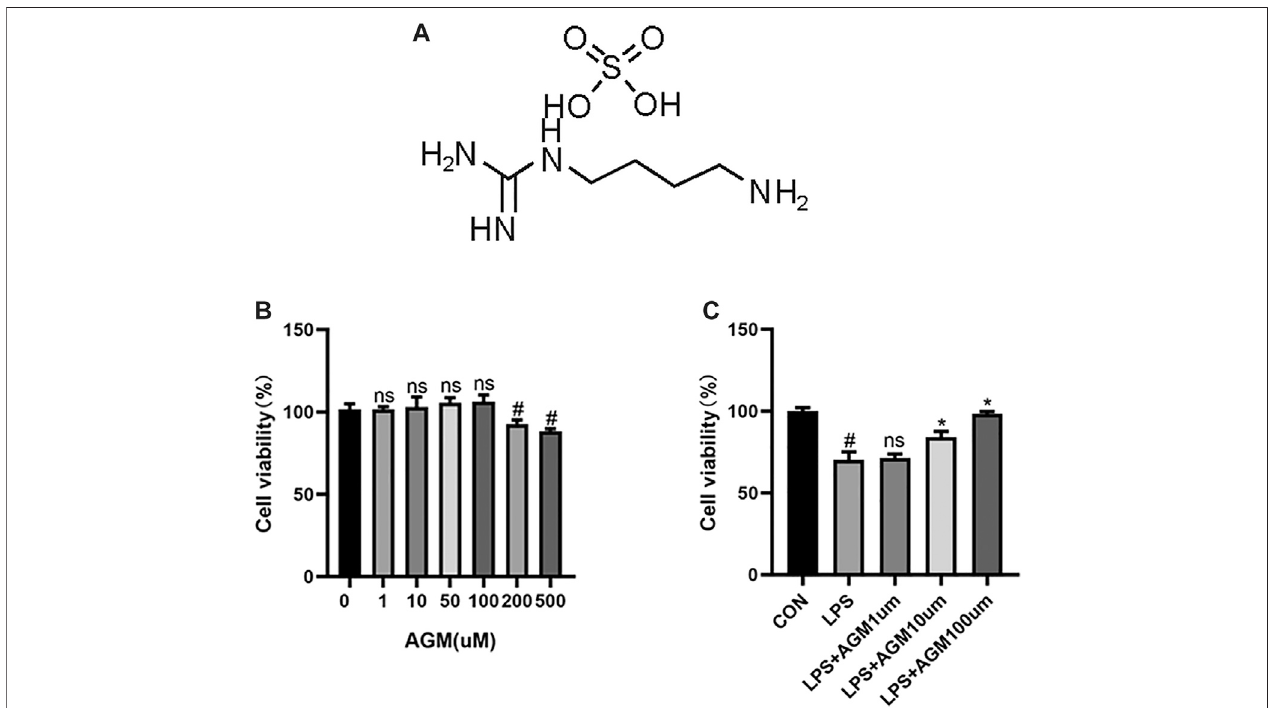
FIGURE 5 | CCK8 analysis of the effect of AGM on viability of BV2 microglial cells. (A) Structure of AGM. (B) Viability of BV2 microglial cells treated with AGM in graded concentrations(0,1,10,50,100,200,500)wasmeasured byCCK8assay(one-wayANOVAfollowedbyDunnett ’ stest). (C) ViabilityofBV2microglialcellstreated with AGM in graded concentrations (1,10,100) was measured by CCK8 assay (one-way ANOVA followed by Dunnett ’ s test). All data are shown as mean ± standard deviation.# p ＜ 0.05 vs the control and LPS group, * p ＜ 0.05 vs the LPS group and LPS + AGM group.